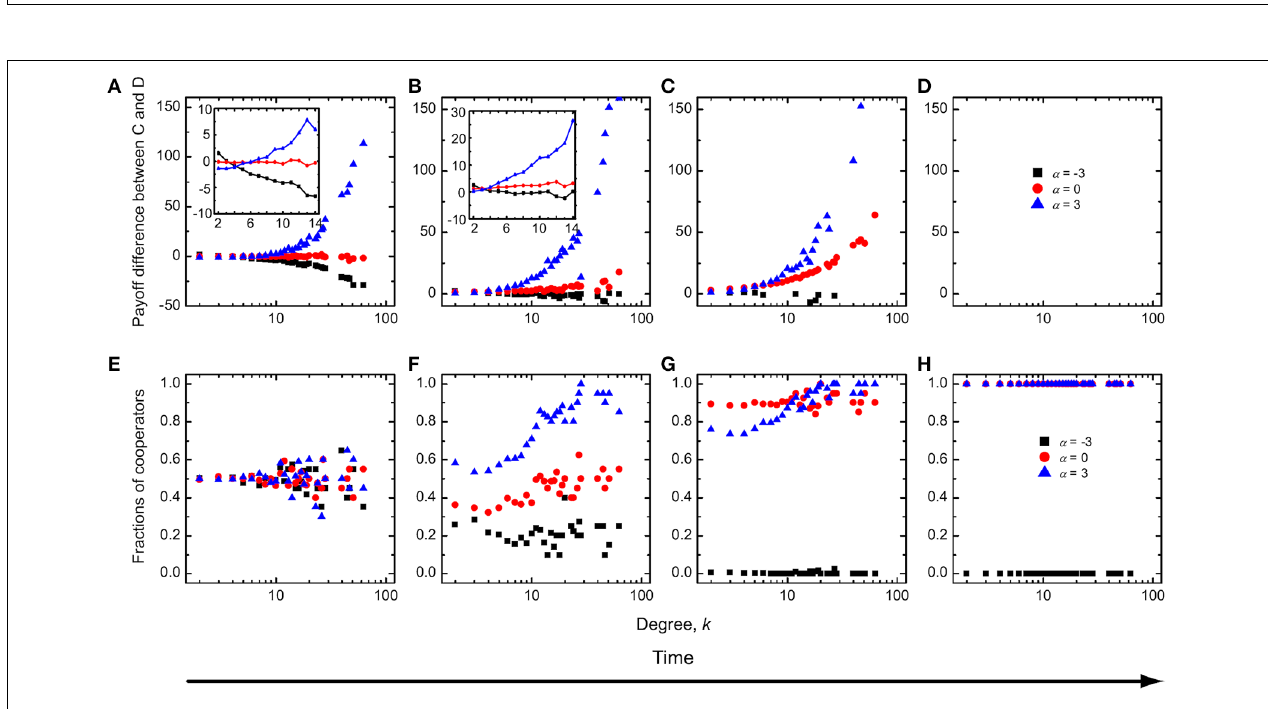
for low-degree and middle-degree nodes during the early stages of evolution. During the evolutionary process, if the enhancement factor is small, cooperators always have a higher mean payoff than defectors at an intermediate value of δ . Parameter values are r = 1 and δ = 0 . 5.